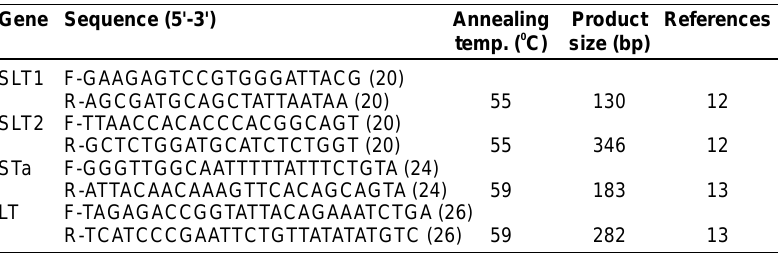
Table-1. Oligonucleotide primer sets used in PCR Gene Sequence (5'-3')